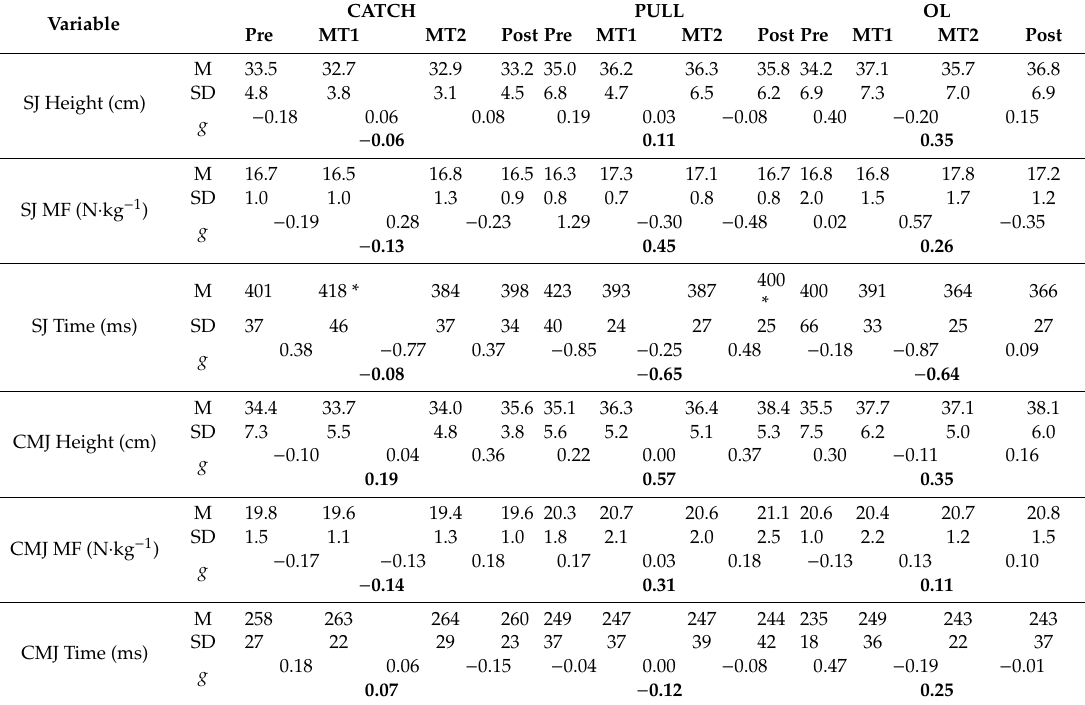
Table 5. Descriptive squat jump (SJ) and countermovement jump (CMJ) from each testing session. CATCH PULL OL Variable